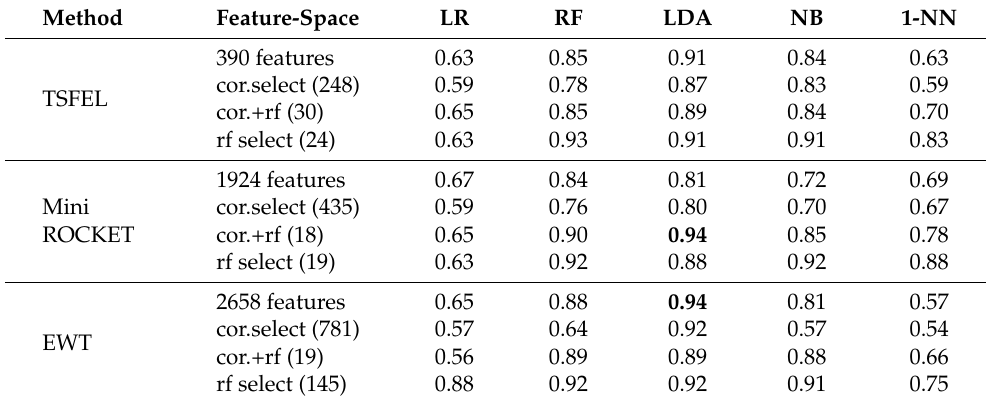
Table 1. Accuracy of classification.